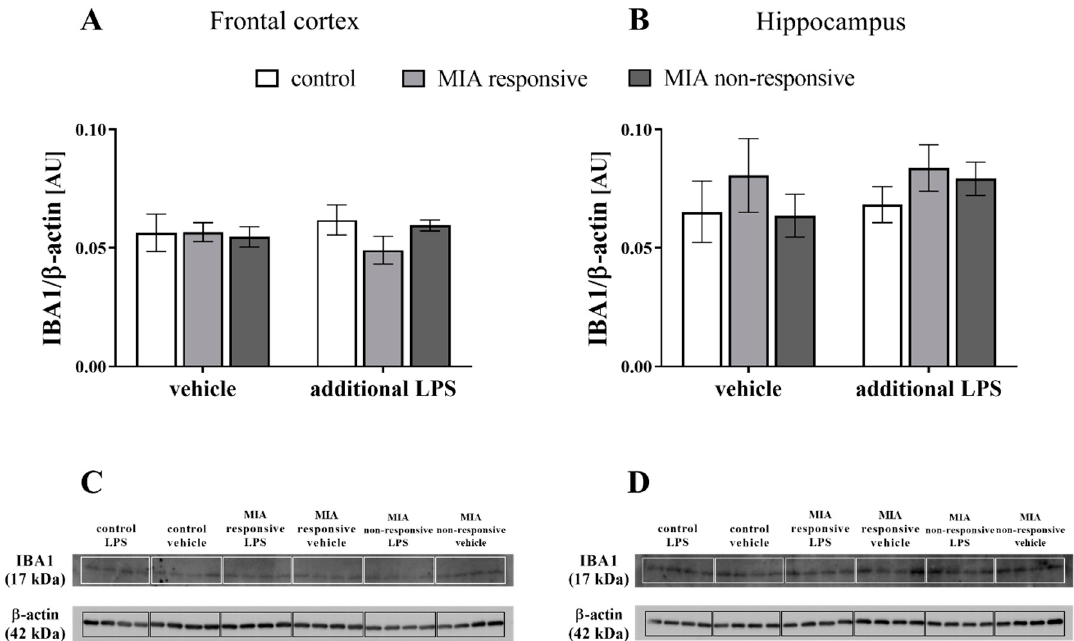
Figure 8. The effect of MIA and the additional acute challenge with LPS on the protein level of IBA1 the frontal cortices ( A ) and hippocampi ( B ) of male Sprague-Dawley o ff spring at PND120. n = 4 in each in the frontal cortices ( A ) and hippocampi ( B ) of male Sprague-Dawley offspring at PND120. n = 4 in group. The results are presented as IBA1 / β -actin ratio ± SEM. ( C , D ) The representative immunoblots each group. The results are presented as IBA1/ β -actin ratio ± SEM. ( C , D ) The representative for each immunoblots for each group.